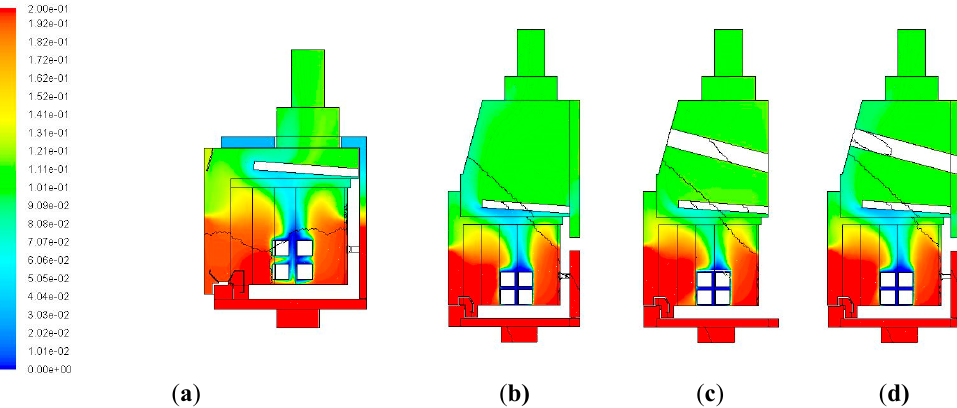
Figure 12. Concentration of O 2 (mole fraction) for ( a ) Case 0, ( b ) Case 1, ( c ) Case 2, ( d ) Case 3.